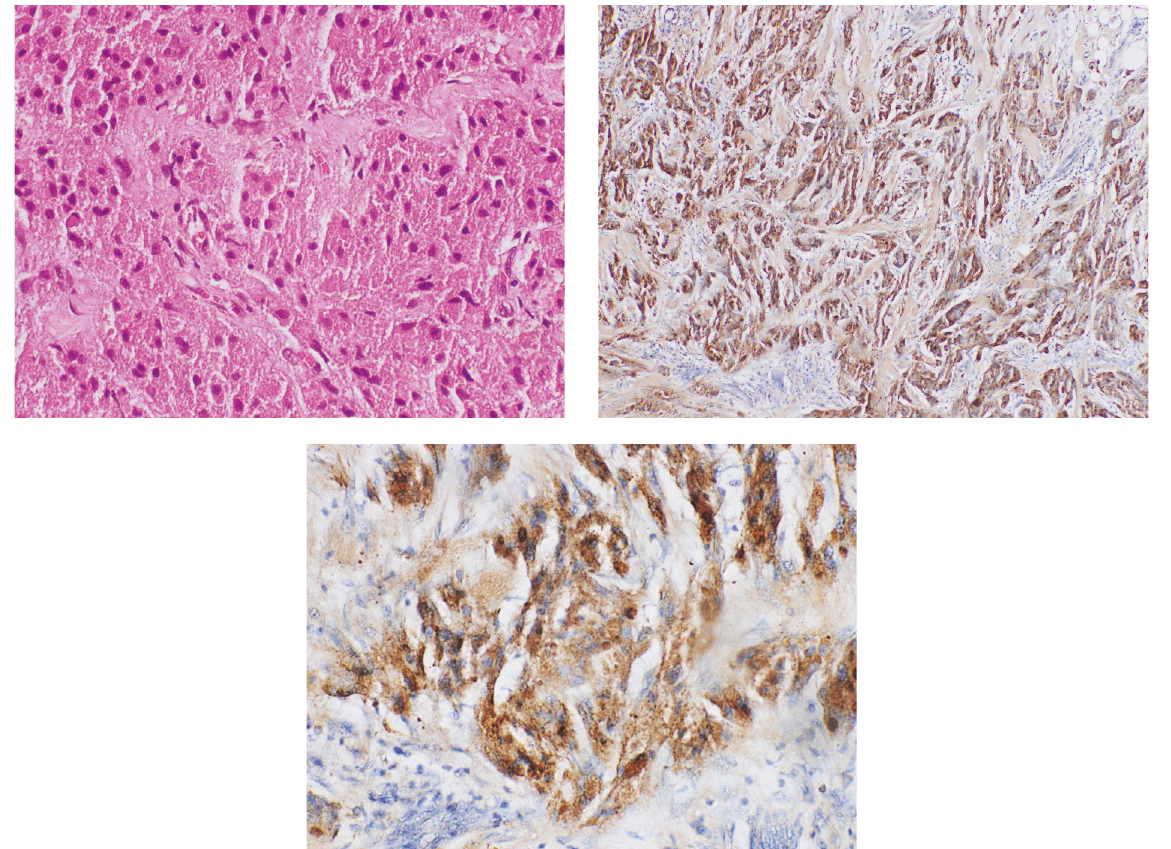
Figure 1: Tumor cells with large and polygonal with abundant eosinophilic granular cytoplasm and small nuclei. (a) Haematoxylin and Eosin staining. (b) and (c) Immunohistochemical staining (S-100),